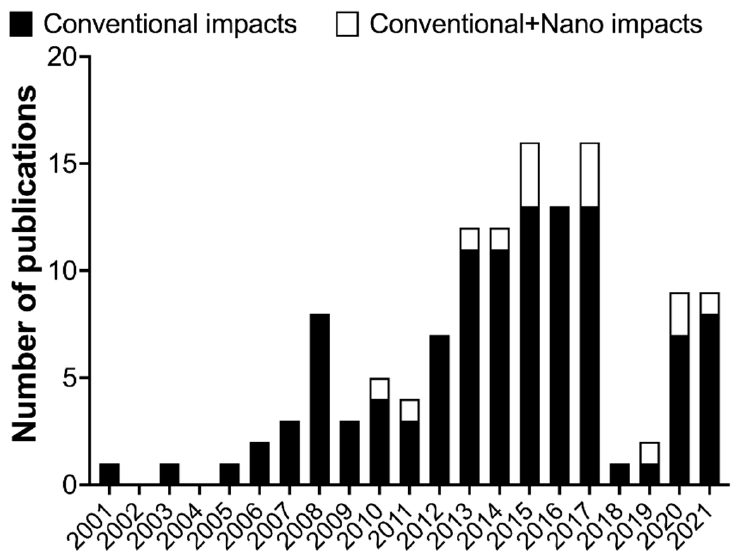
Figure 10. Number of publications related to the LCA in nanotechnology accounting for conventional impacts and also for those impacts linked to the releases of nanomaterials.